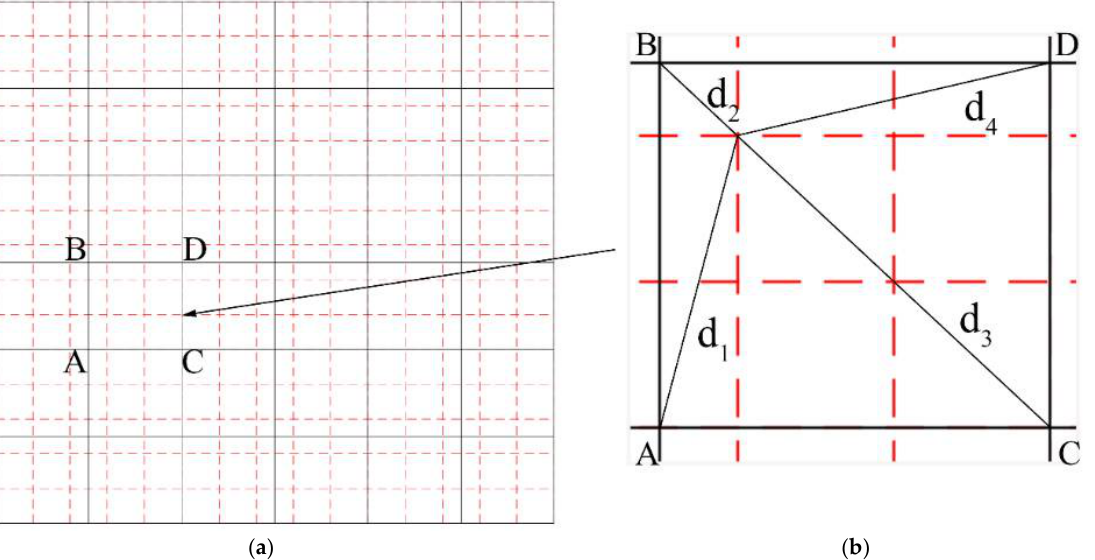
Figure 2. Mapping from the coarse grid (temperature) to the fine grid (fluid flow) ( a ). The properties at any node in the fine grid are determined from the four nearest neighbor nodes of the coarse grid ( b ).